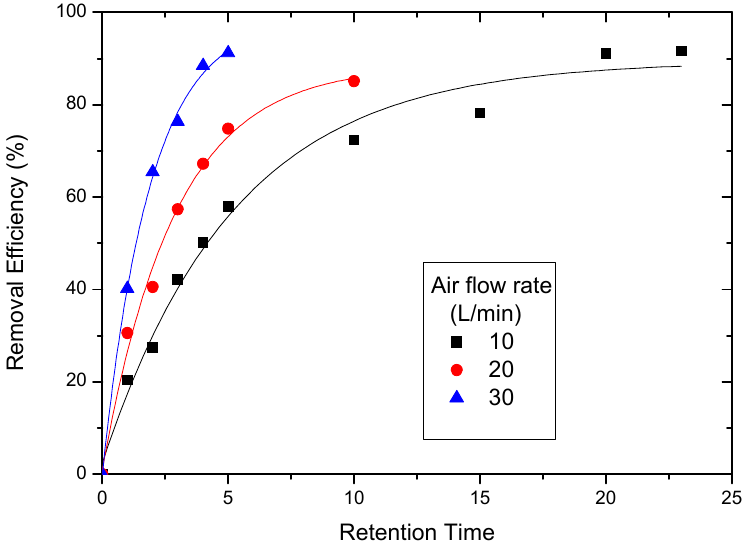
Figure 6. Effect of the air flow rate on the efficiency of HFC-134a removal. (Initial HFC-134a conc.: 772 mg/L, liquid circulation rate: 80 L/min).